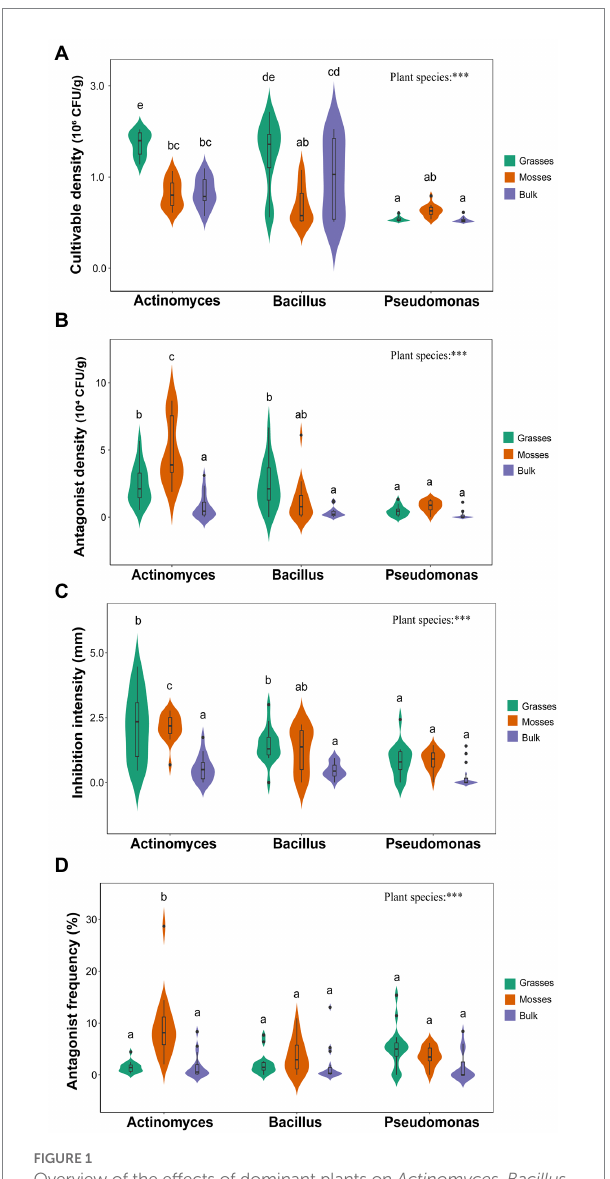
FIGURE 1 Overview of the effects of dominant plants on Actinomyces , Bacillus , and Pseudomonas antagonistic interactions (A) Total cultivable density of bacteria (B) the antagonistic density of bacteria (C) the radius of inhibition zone (D) the proportion of inhibitory Actinomyces , Bacillus and Pseudomonas . Abbreviations: Letters (a,b,c,…) above each bar represent the significance among genera (Tukey’s HSD). P ′ indicates significant effects at *** p <